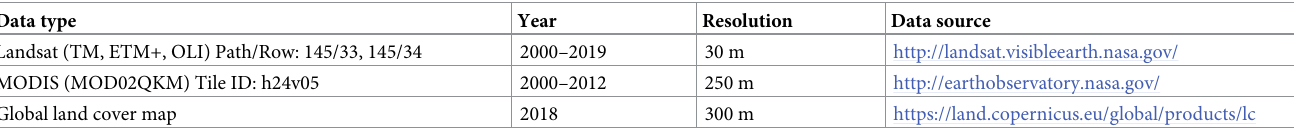
Table 1. Summary of the remote-sensing data and data sources used in the